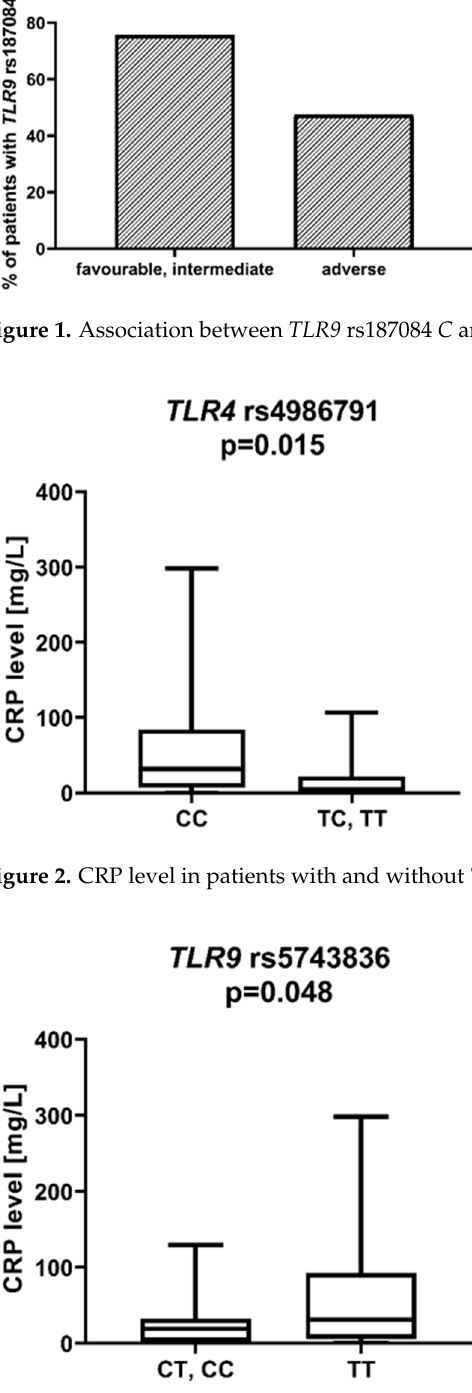
Figure 3. CRP level in patients with and without TLR9 rs5743836 C